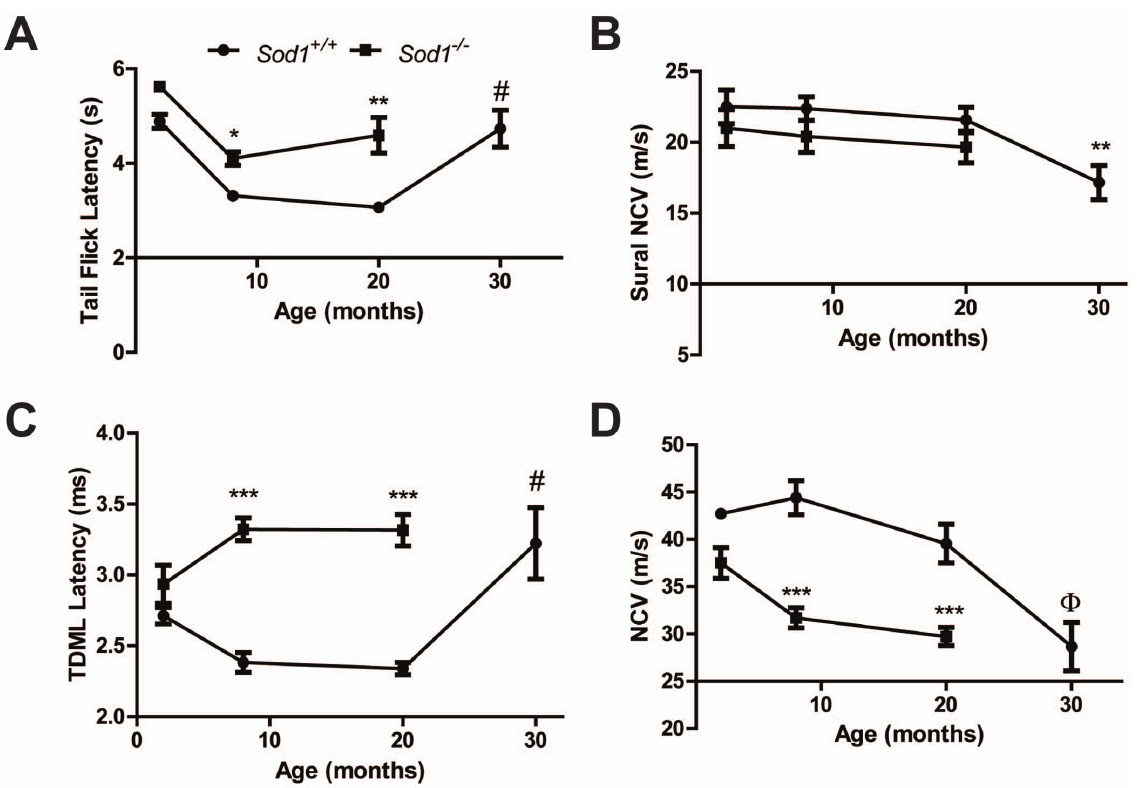
Figure 3. Behavioral and functional measures of sensory and motor nerve function in Sod1 mice. A) The behavioral tail flick response to a thermal stimulus in the Sod1 + / + mice at 2, 8, 20, and 30 mo (n=7, 16, 10, and 7, respectively) and Sod1 2 / 2 mice at 2, 8 and 20 mo (n=4, 21, and 8, respectively) is a measure of both sensory and motor nerve function. B) Sensory nerve function was assessed using sural nerve conduction velocity (NCV) in the Sod1 + / + mice at 8, 20, and 30 mo (n=13, 9, and 12, respectively) and Sod1 2 / 2 mice at 8 and 20 mo (n=10 and 7, respectively). Motor nerve function was examined by measuring C) Tail distal motor latency (TDML) in the Sod1 + / + mice at 2, 8, 20, and 30 mo (n=8, 21, 12, and 9, respectively) and Sod1 2 / 2 mice at 2, 8 and 20 mo (n=6, 17 and 4) and by measuring D) sciatic motor NCV in the Sod1 + / + mice at 2, 8, 20, and 30 mo (n=7, 15, 7, and 9, respectively) and Sod1 2 / 2 mice at 2, 8 and 20 mo (n=6, 19 and 6). *p , 0.05, **p , 0.01, and ***p , 0.0001 compared to age- matched Sod1 + / + mice; W p , 0.01 and # p , 0.0001 compared to Sod1 + / + mice at 20